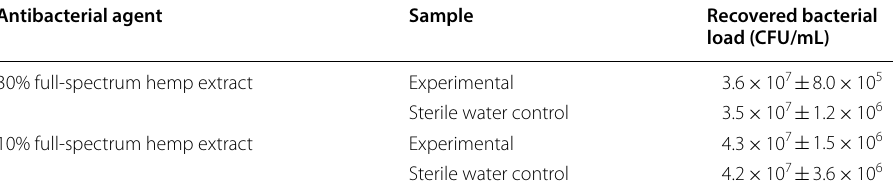
Values reported are average and standard error of the mean of bacterial load recovered